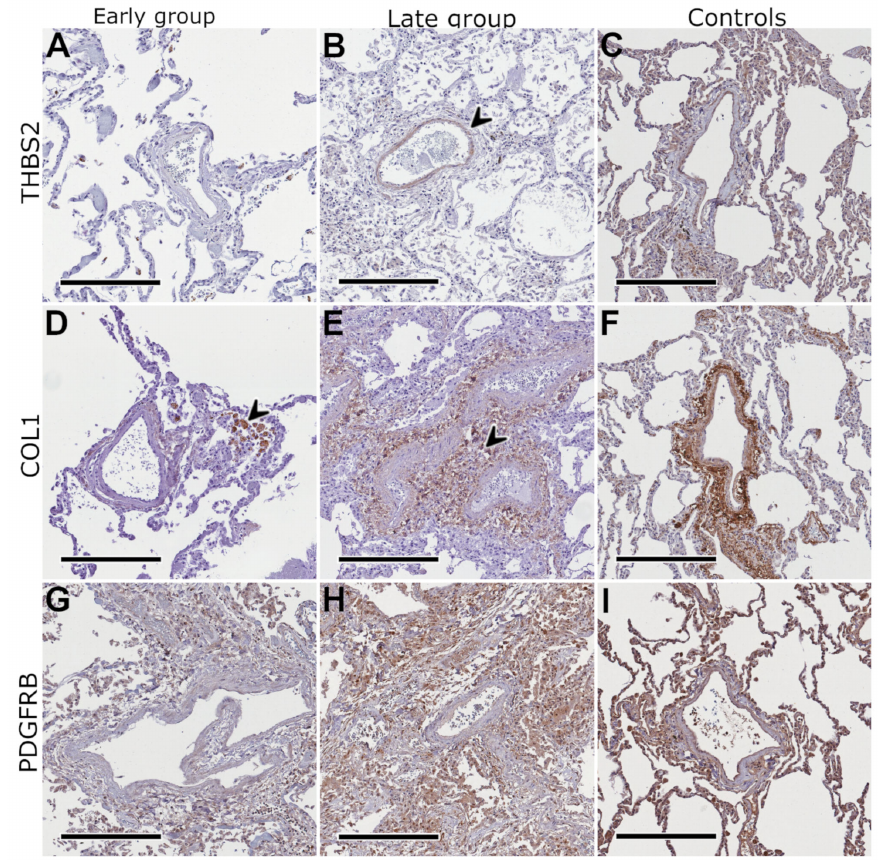
Figure 4. Immunostaining II. Thrombospondin 2 (THBS2) showed no enhancement in the early group ( A ) and a specific but slight enhancement in the media layer of pulmonary artery branches in the late group ( B ); collagen 1 (COL1) was enriched in macrophages (arrow) and minimally also in the perivascular stromal tissue in the early group ( D ) compared to a highly specific and powerful staining of the considerably augmented perivascular stromal tissue (arrow) in the late group ( E ); platelet-derived growth factor receptor beta (PDGFRB) showed a diffuse low-intensity enhancement in macrophages and in the walls of pulmonary artery branches in the early group ( G ) compared to an extensive enhancement predominantly in macrophages and ECM structures in the late group ( H ); compared to the autopsy samples, staining appeared more intensive in healthy controls ( C , F , I ), presumably due to the higher tissue integrity; scale bars equal 300 µ m in all